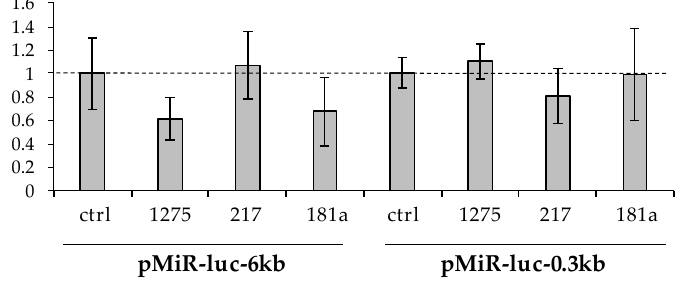
Figure 5. Effects of Pax-5 3′UTR shortening on miRNA regulation. ( A ) Relative expression levels of miR-1275, miR-217, and miR-181a were determined in Raji and REH B-cell lines using TaqMan qPCR. Expressed levels were normalized and plotted in relative fold log expression over control samples (RNU48 expression). ( B ) REH cells were transiently transfected with anti-microRNA (anti-miR) inhibitors against miR-1275, miR-217, and miR-181a for 48 h. MiRNA silencing was then evaluated by TaqMan qPCR and compared to their respective transfected non-targeting controls (scrambled). MiRNA levels were normalized and plotted in relative expression over control samples (scrambled anti-miRs). ( C ) REH cells were transiently co-transfected with pMiR reporter constructs (pMiR-6kb versus pMiR-0.3kb) and anti-miR inhibitors (1275, 217, and 181a) then evaluated for relative luciferase activity. Relative light units (RLUs) were normalized and plotted in relation to control samples (scrambled anti-miRs) represented by a dotted line. The presented data are the calculated means of three independent biological assays, where statistical analysis by t -test indicates significant differences in respect to controls (*** p < 0.001).